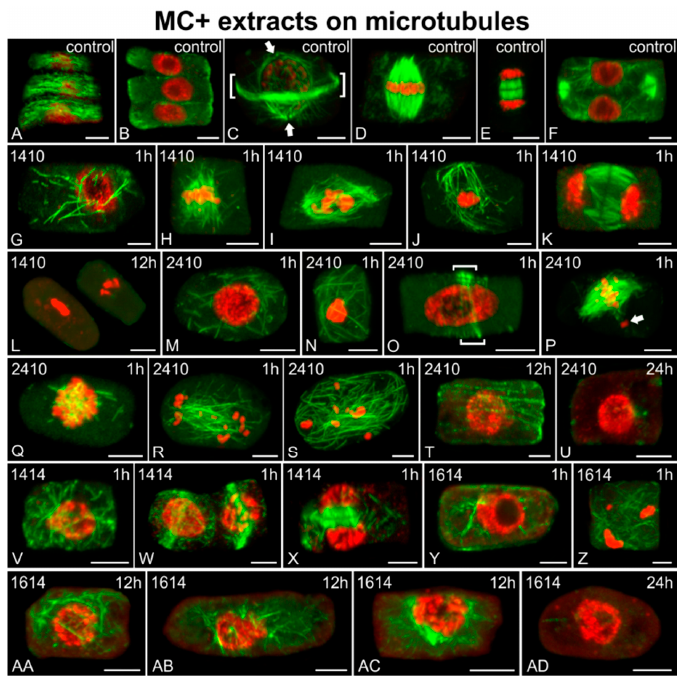
Figure 11. Single cortical ( A ), single central ( B , K , X , Y ), and maximum intensity projections of serial CLSM sections ( C – J , L – W , Z – AD ) of Oryza sativa root meristematic cells, after α -tubulin immunostaining (green) and DNA staining with DAPI (pseudo-coloration in red). Cells depicted are either control ( A – F ) or treated for various time periods (indicated on each image) with MC+ extracts from MC-producing cyanobacterial strains: Microcystis flos-aquae TAU-MAC 1410 ( G – L ), Microcystis sp. TAU-MAC 2410 ( M – U ), Raphidiopsis raciborskii TAU-MAC 1414 ( V – X ), and Trichormus variabilis TAU-MAC 1614 ( Y – AD ). Images A and B depict the same cells at cortical and central sections. A – F . Control cells at interphase exhibit dense, transverse cortical microtubules ( A ) and no endoplasmic microtubules ( B ). Preprophase/prophase cells exhibit the typical preprophase band (PPB) of microtubules (brackets in C ), as well as perinuclear microtubules converging on two distinctive poles (arrows in C ). Mitotic spindles with aligned chromosomes at the equator can be observed in metaphase cells ( D ) and control cytokinetic cells exhibit typical phragmoplasts (early stage in E and later stage in F ). 1410 : After 1 h of treatment, scarce and disoriented interphase microtubules were observed ( G ). Abnormal mitotic spindles were detected ( H , I ), along with cells exhibiting misoriented microtubules and abnormal chromatin condensation ( J ). Abnormally elongated phragmoplast microtubules were observed in cytokinetic cells ( K ). The 12 h of treatment led to the complete disappearance of microtubules, with chromatin also appearing highly condensed ( L ). 2410 : After 1 h, short and disorganized microtubules were observed not only in interphase cells ( M ), but also in cells with uncommon chromatin condensation ( N ). Preprophase cells lacking perinuclear microtubules ( O ) were spotted, along with distorted mitotic spindles (note the misaligned chromosome outside the spindle, pointed with arrow in P ). Affected cells of undefined chromatin state exhibited extremely short ( Q ) or misplaced and disoriented microtubules ( R , S ). After 12 h, only interphase cells with a sparse microtubule network were encountered ( T ), which eventually collapsed after 24 h ( U ). 1414 : After 1 h of treatment, disorientation was common for both interphase ( V ) and perinuclear microtubules in preprophase cells ( W ), as well as phragmoplast microtubules in affected cytokinetic cells ( X ). Harsher e ff ects were not recorded after longer treatments. 1614 : After 1 h of treatment, a ff ected cells exhibited scarce and misoriented microtubules ( Y ) and, in some cases, abnormally condensed and scattered chromatin ( Z ). After 12 h, disorientation of the microtubule network could still be observed in interphase ( AA ), also with abundant short perinuclear microtubules ( AB ). Preprophase cells without a PPB were recorded ( AC ). After 24 h, almost no tubulin polymers could be detected ( AD ). Scale bars: 5 µ